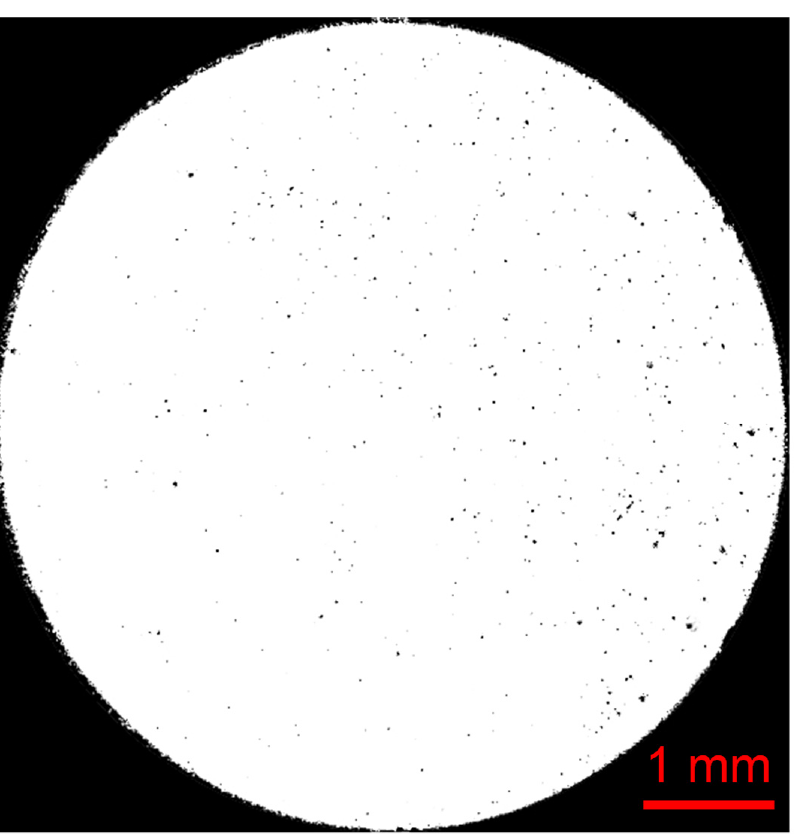
Figure 4. Porosity analysis assisted by image-processing software (porosities are highlighted as dark pixels over a white landscape): a sample of the HMP-U set with 0.4% porosity level. Each S-N fatigue curve is plotted in the finite life domain with the related confidence band in Figure 5A–C; moreover, their trends and corresponding strengths are compared in Figure 6A. The general linear test always led to the conclusion that the enhancement yielded by the second-order model was always under the significance threshold. Therefore, the linear model was utilized for all the sample sets instead, and was also applied in the framework of the MLE approach. The curve trends following the latter methodology are displayed in Figure